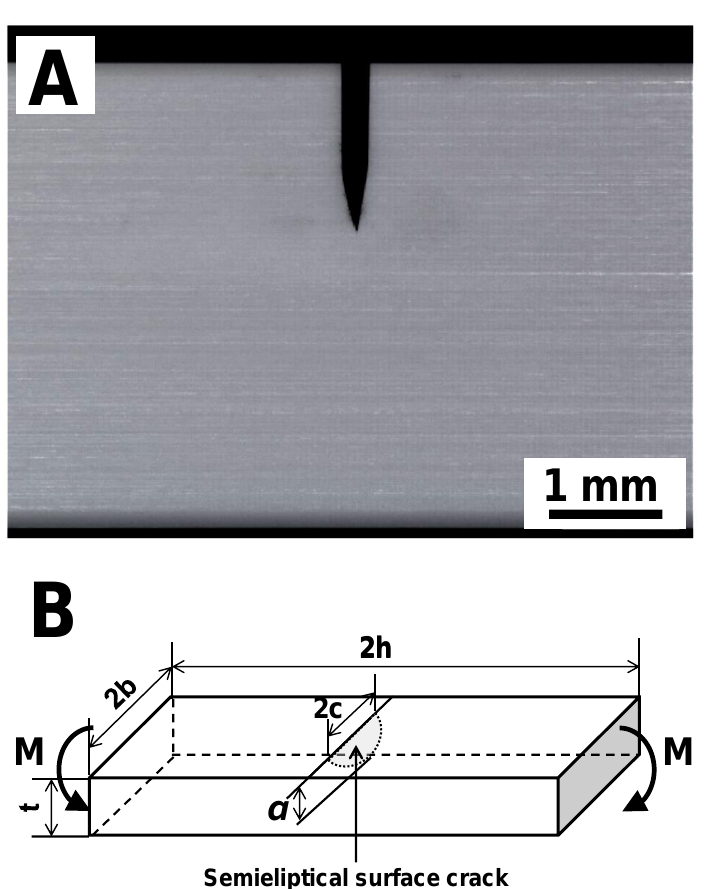
Figure 6. Critical defects in ceramics that are used for the calculation of fracture toughness. ( A ) A photo of a V-notch cut placed in the ceramic sample on the surface under applied tensile stress for SEVNB tests, ( B ) a schematic presentation of a semielliptical surface crack used in K 1c calculation proposed in [32].